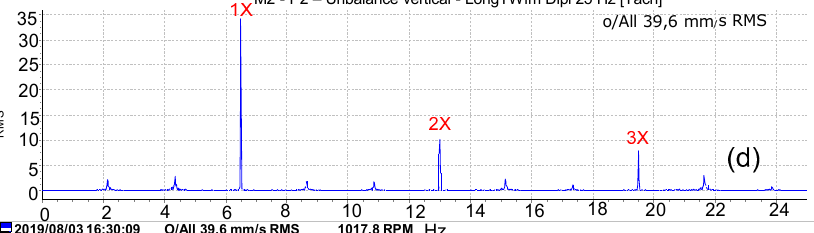
Figure 9. Experimental response of lateral-torsional coupled Cardan shaft with a crack: ( a , b ) vertical deflection of drive and driven shaft and ( c , d ) frequency spectrum of shaft 1 and shaft